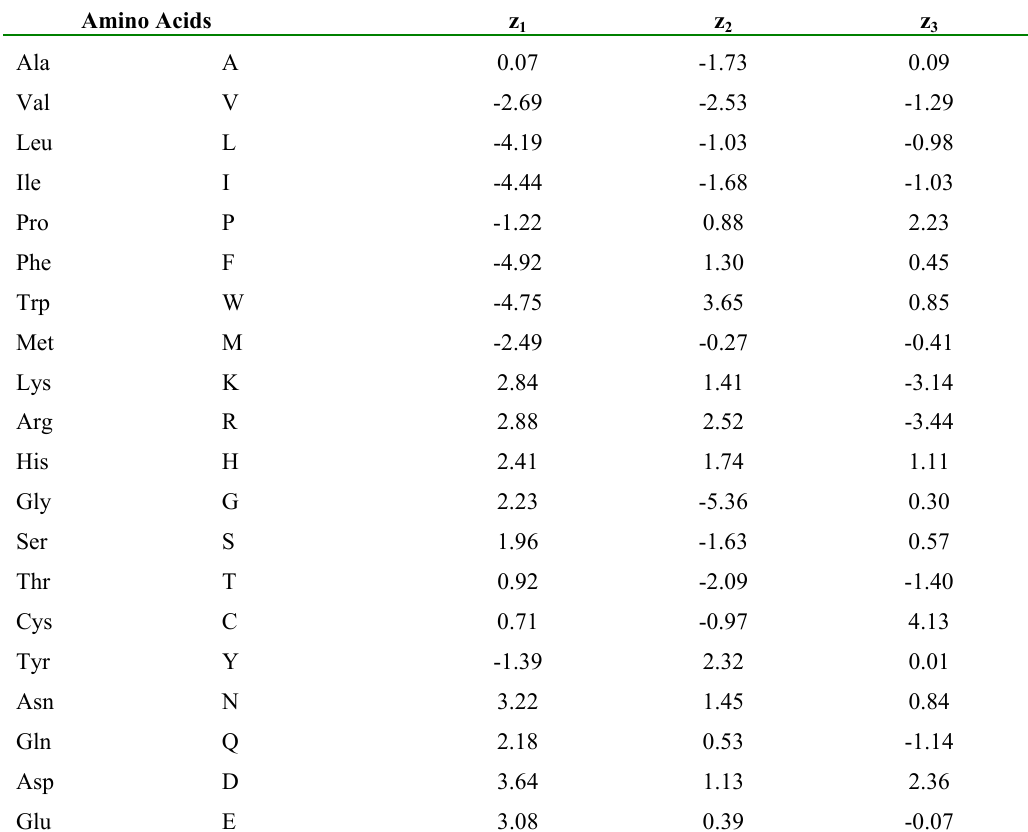
, z and z for the Natural Amino Acids [40, 1 2 3